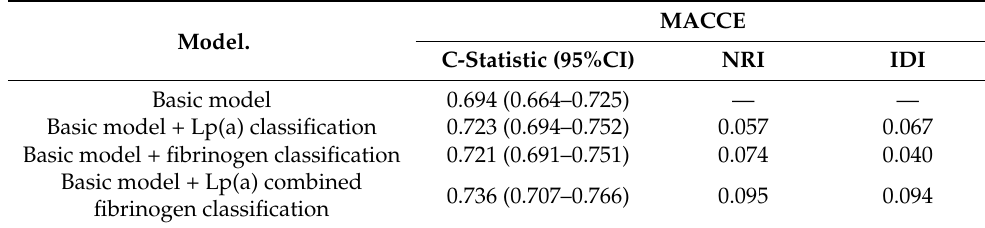
Table 4. The comparison between four MACCE risk forecast model.